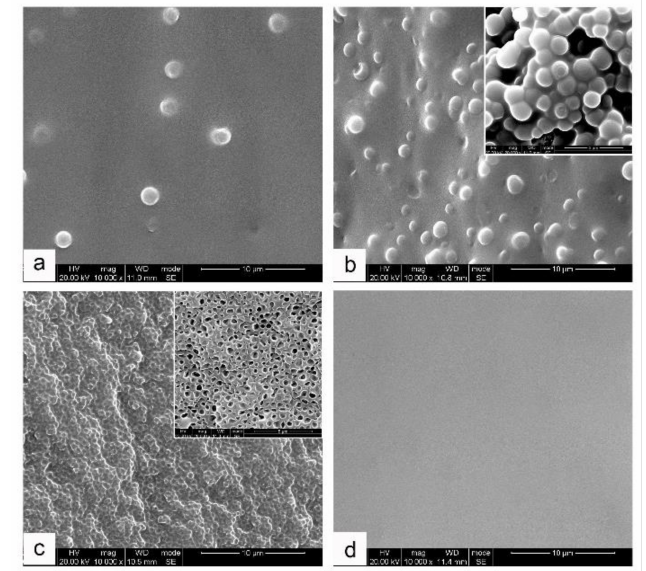
Figure 4. SEM morphology of MOEA-BOZ/DGEBA-ER/IMZ (12 wt%) blends with different content of ER after curing at 110 ◦ C for 17 h: ( a ) 10 wt%, ( b ) 30 wt%, ( c ) 50 wt%, and ( d ) 70 wt%; the insert pictures were obtained after etching with THF for 5